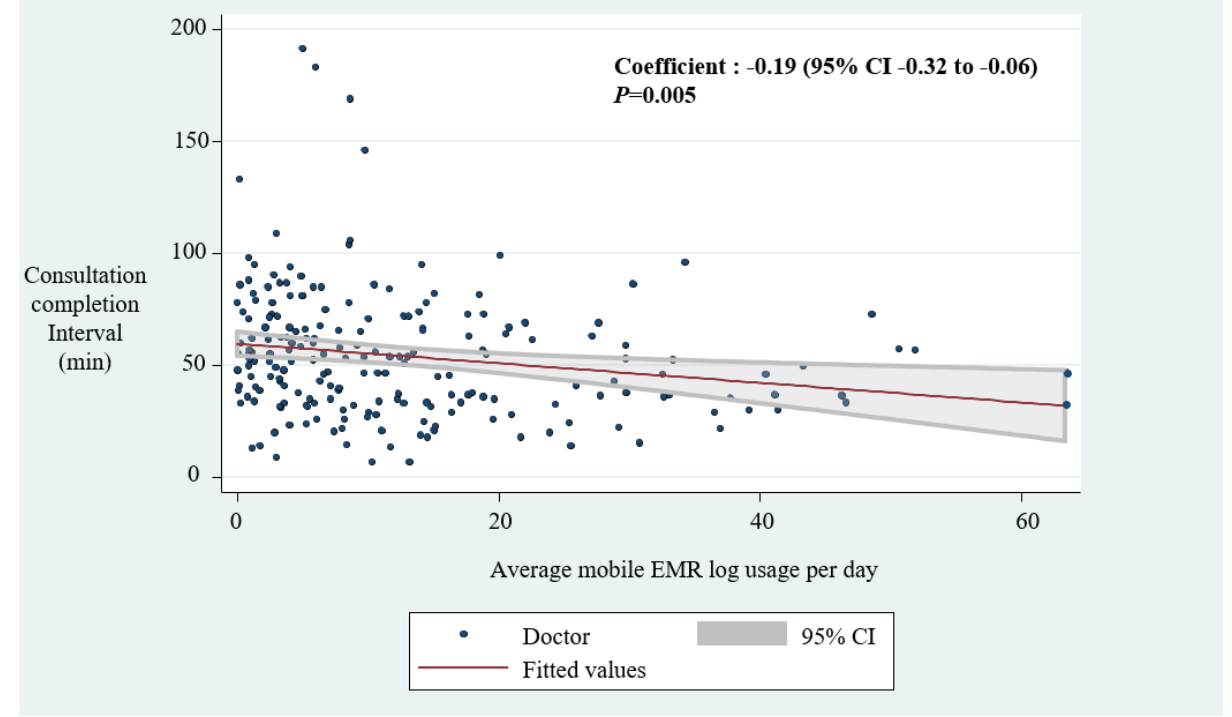
Figure 5. The correlation between consultation completion interval and mobile electronic medical record frequency. EMR: electronic medical record.